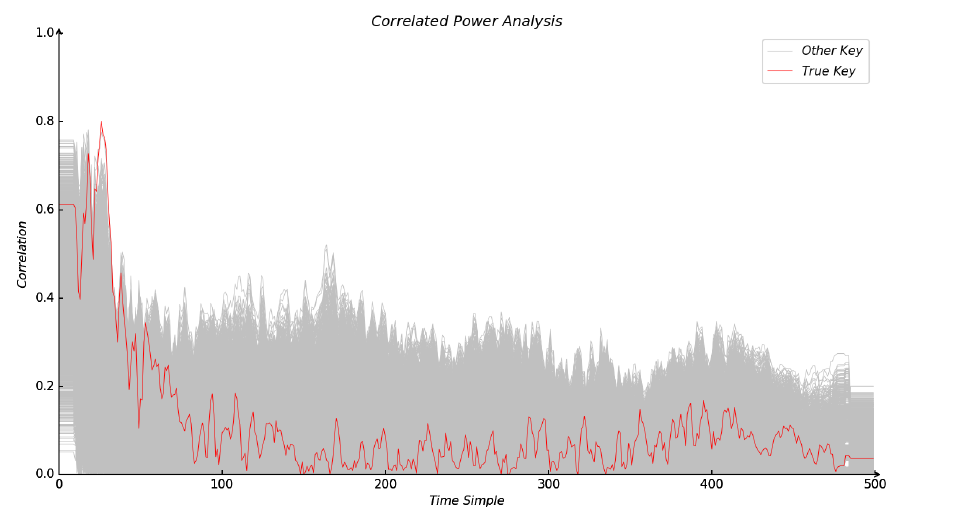
Figure 11. Group A: CPA result of experiment of all 12 rounds calculated by hardware.